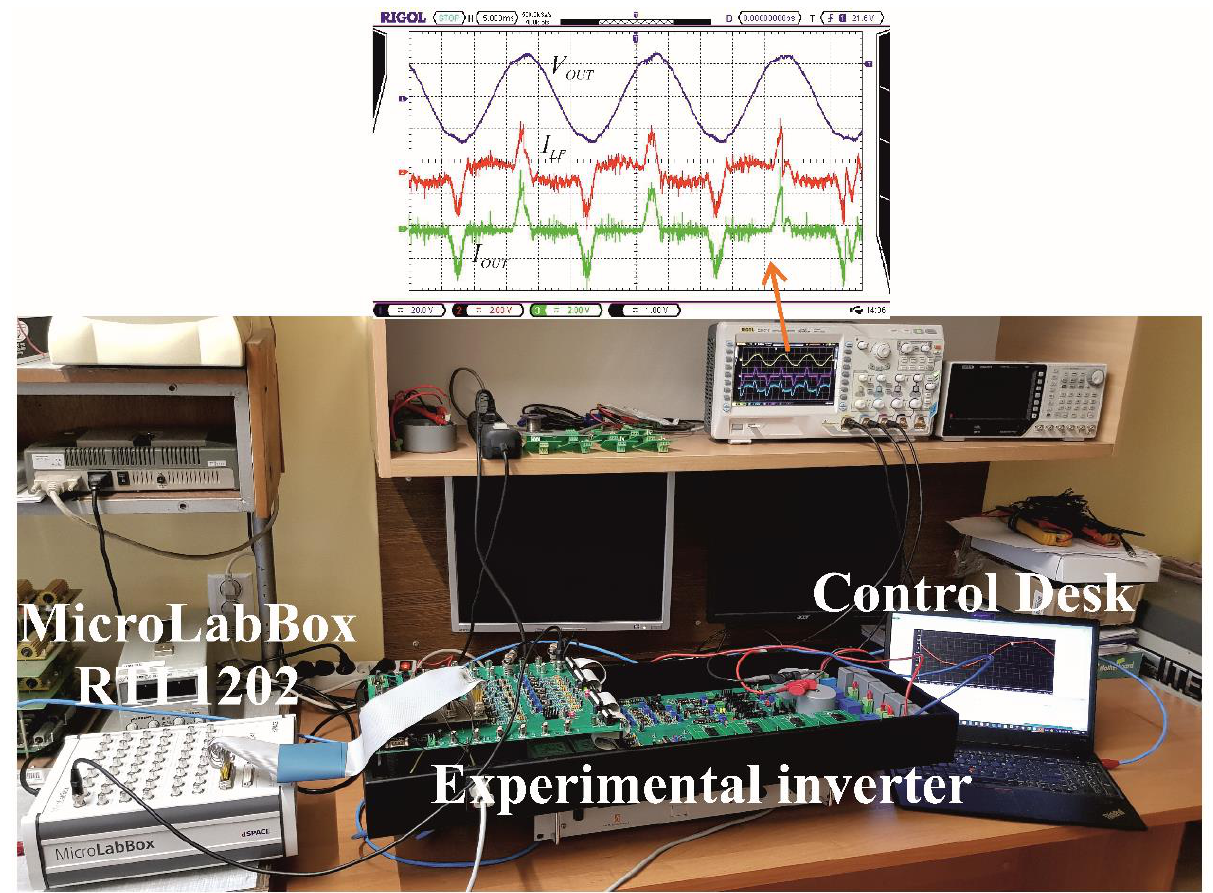
Figure 6. The real-time interface of the dSpace simulation blocks and the experimental inverter using MicroLabBox RTI1202.